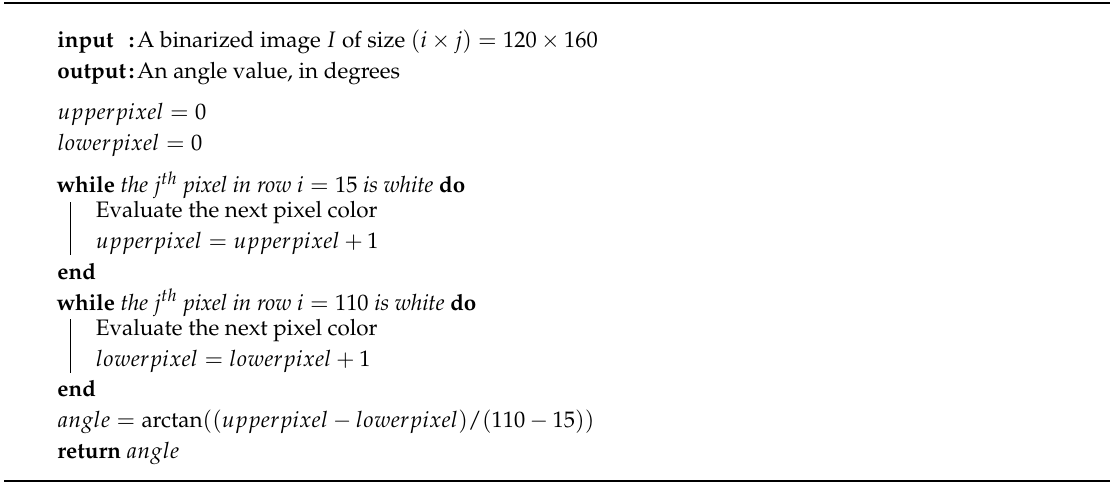
Algorithm 2: Reference line angle determination.